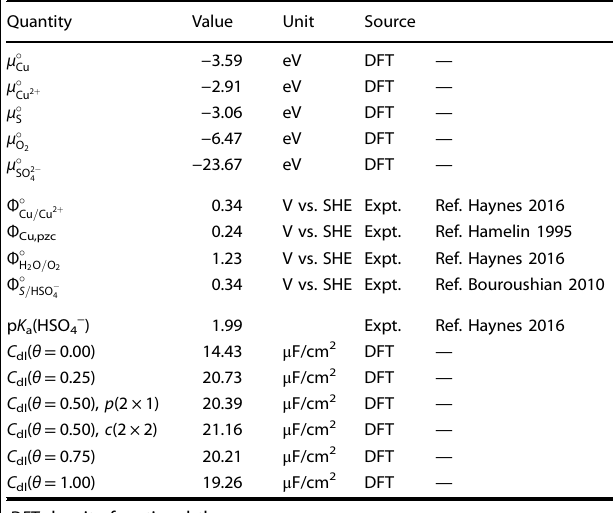
Table 1. Thermodynamic data used to de fi ne reference energies